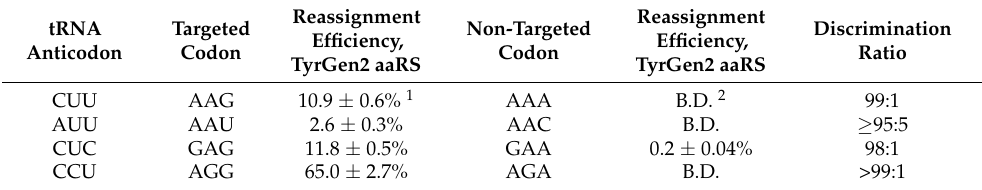
Table 3. Discrimination between targeted and non-targeted codons by orthogonal M. barkeri